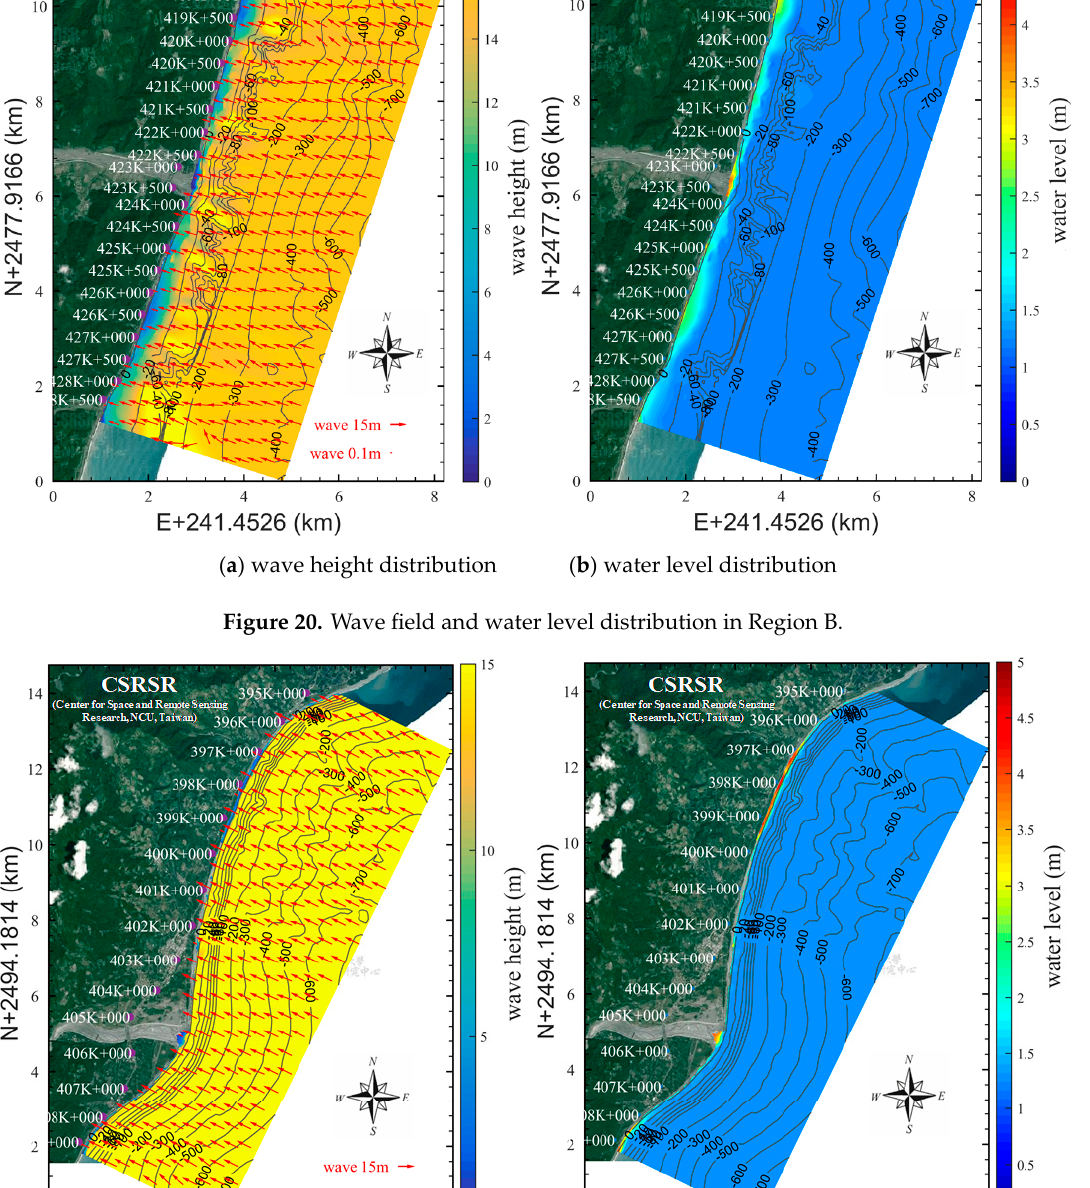
Figure 21. Wave field and water level distribution in Region C.